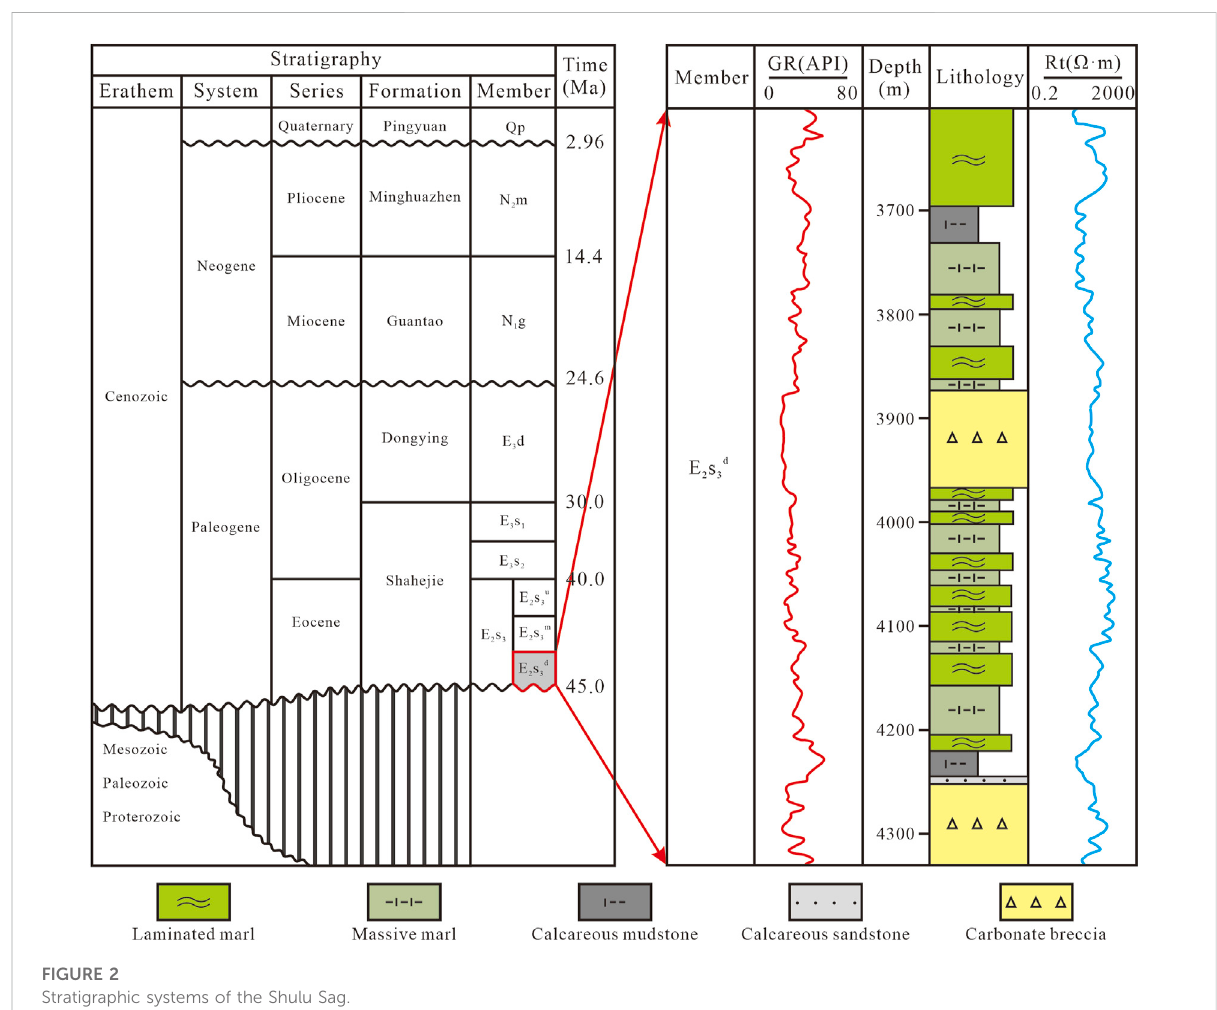
FIGURE 2 Stratigraphic systems of the Shulu